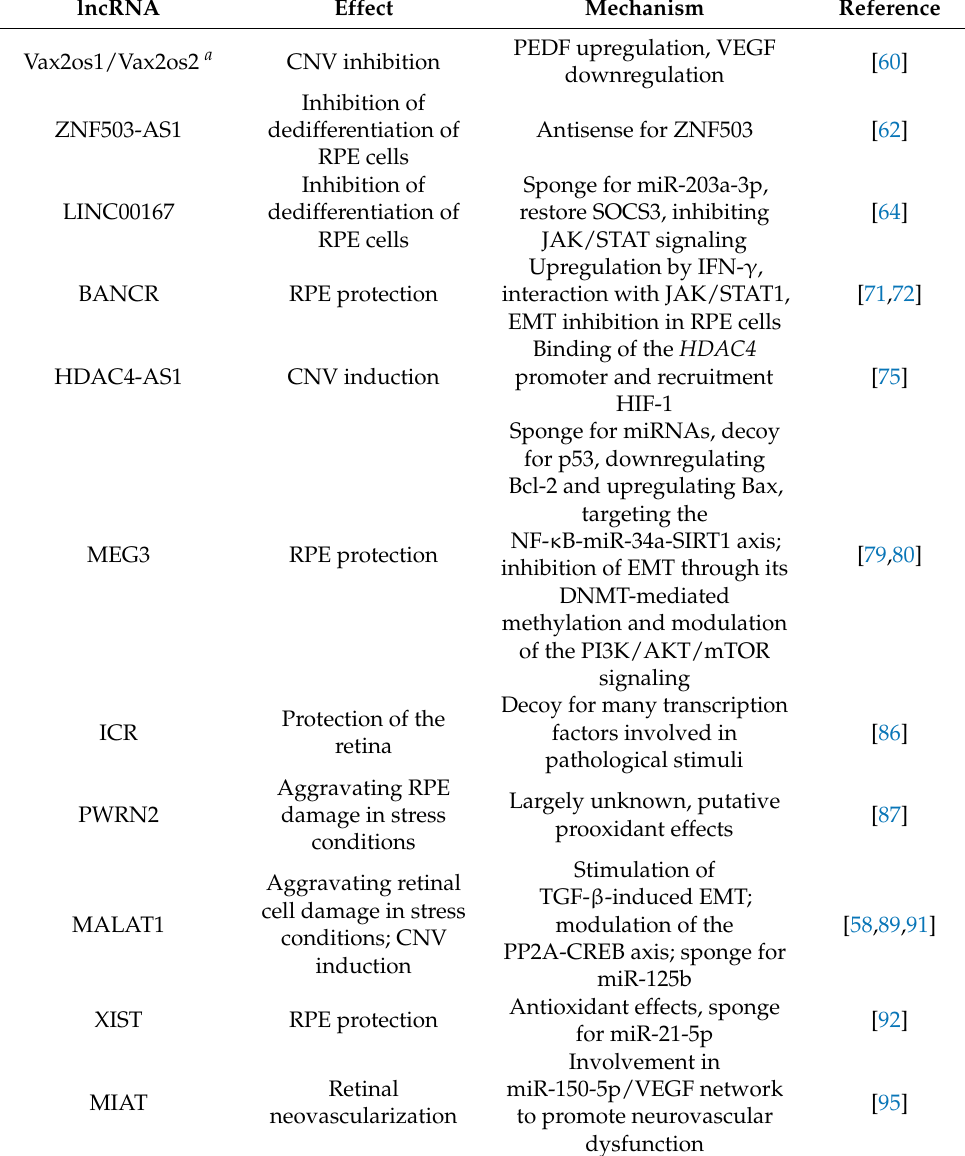
Table 1. Effects and mechanisms of long non-coding RNAs (lncRNAs) in retinal cells potentially important in age-related macular degeneration